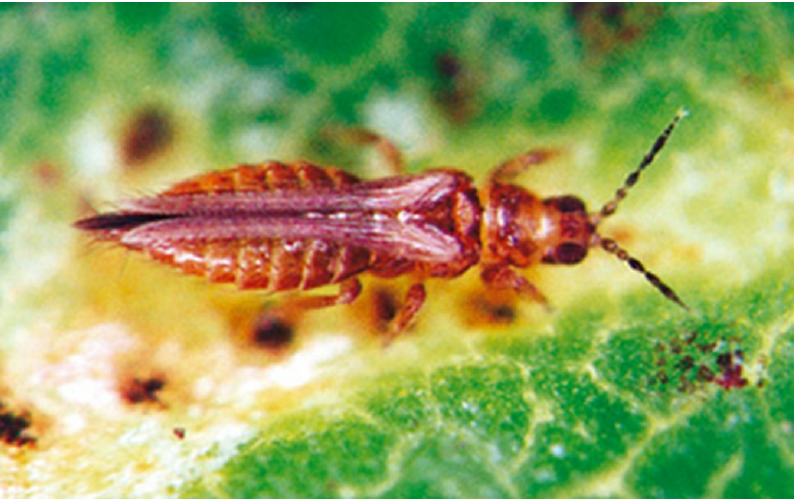
Figure 1. Enneothrips enigmaticus sp. n., female, on peanut ( Arachis hypogaea ) (Photo: ESALQ Entomological Museum).